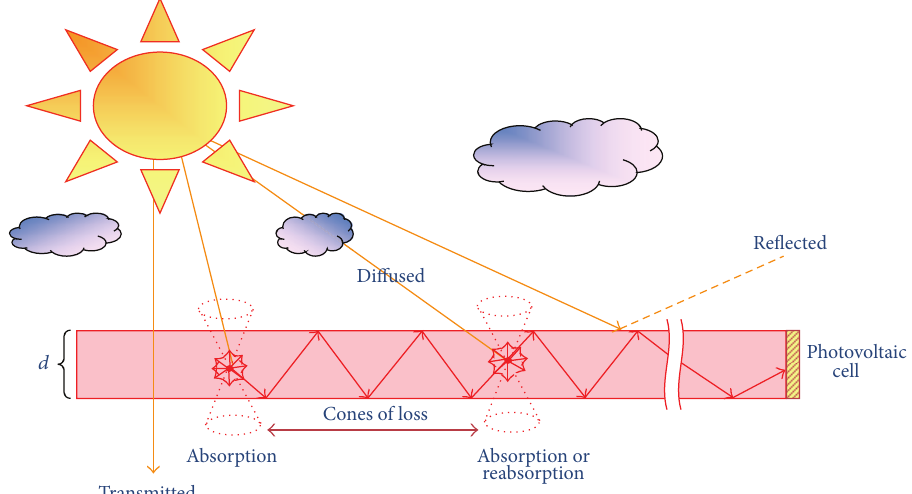
Figure 1: The operation principle of luminescent solar concentration (LSC).